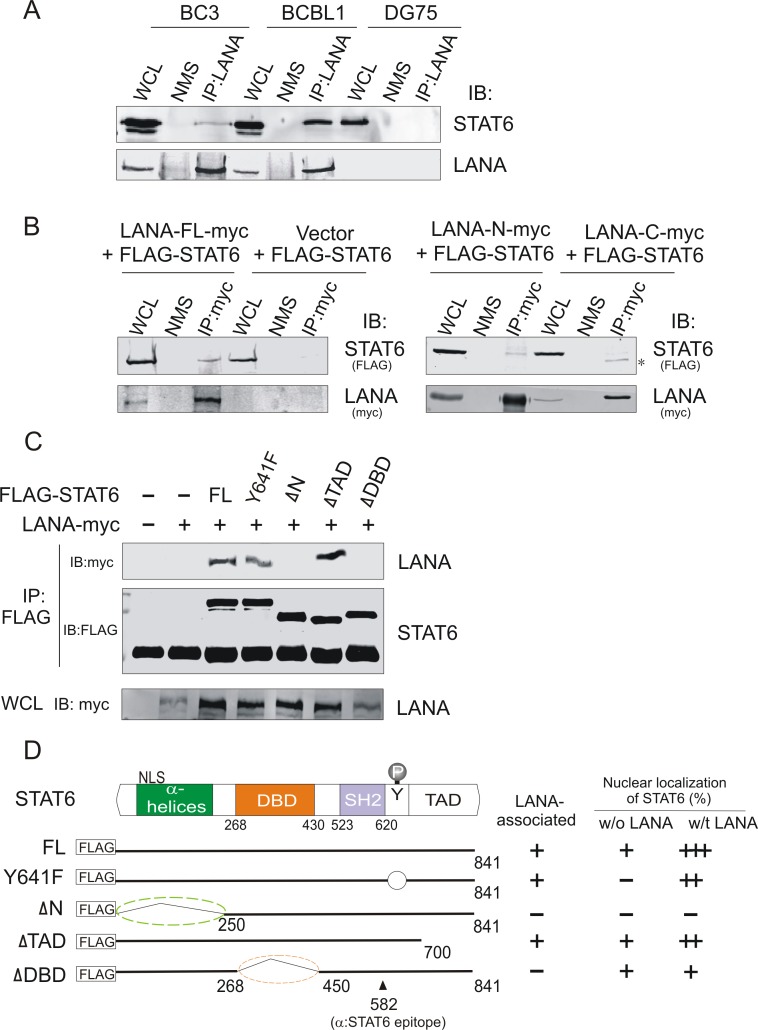
STAT6 is associated with LANA.(A) Endogenous STAT6 interacts with LANA in PEL cells. Whole cell lysates (WCL) from PEL cells (BC3, BCBL1) and B lymphoma cells (DG75) were individually subjected to immunoprecipitation (IP) and immunoblotting (IB) assay as indicated. NMS, normal mouse IgG. (B) LANA interacts with STAT6 and depends on its amino domain. Whole cell lysate (WCL) of HEK293 cells transfected with STAT6 with FLAG tag in the presence of full-length (FL) LANA or its amino (N) or carboxyl (C) truncated mutants with myc tag, were individually subjected to immunoprecipitation (IP) and immunoblotting (IB) with antibodies against Flag and myc epitope. Asterisk indicates a cleaved isoform of STAT6. (C) Exogenous STAT6 interacts with LANA and depends on its amino domain and DNA-binding domain. Whole cell lysate (WCL) of HEK293 cells transfected with STAT6 with FLAG tag in the presence or absence of LANA with myc tag, were individually subjected to immunoprecipitation (IP) and immunoblotting (IB) with antibodies against Flag and myc epitope. (D) Schematic of wild type STAT6 and its truncated mutants with FLAG tag. FL, full length; Y641F, tyrosine 641 mutated into phenylalanine 641; DBD, DNA-binding domain; TAD, Transactivation domain; NLS, nuclear localization sequence. The epitope (position 582) recognized by the STAT6 (D3H4) antibody is indicated. The relative ability of STAT6 binding with LANA and percentage of STAT6 nuclear localization is individually summarized from the data of Fig 3C and supplementary S1 Fig and shown on the right panel.